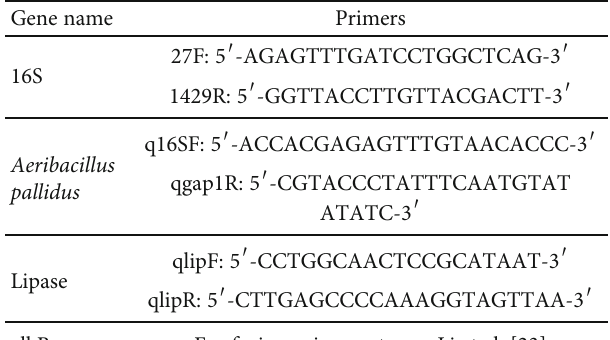
Table 1: Real-time quantitative PCR analysis